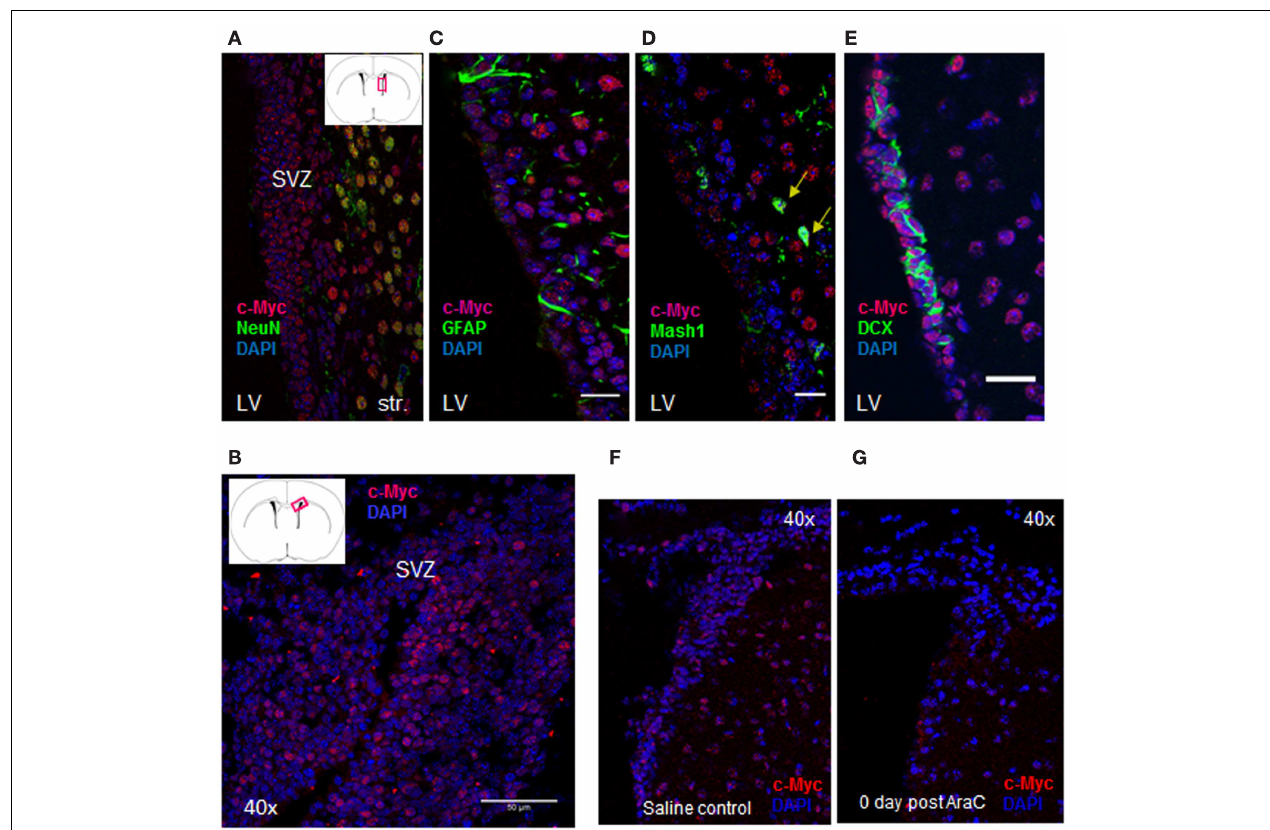
marked by arrows. LV: lateral ventricle; Str: striatum (12 µ coronal sections; 40 × oil; scale bar = 50 µ m). Anti-mitotic treatment abolished most of c-Myc expressing cells after Ara-C treatment; (F, G) Indicating c-Myc is highly expressed in progenitors and neuroblasts in